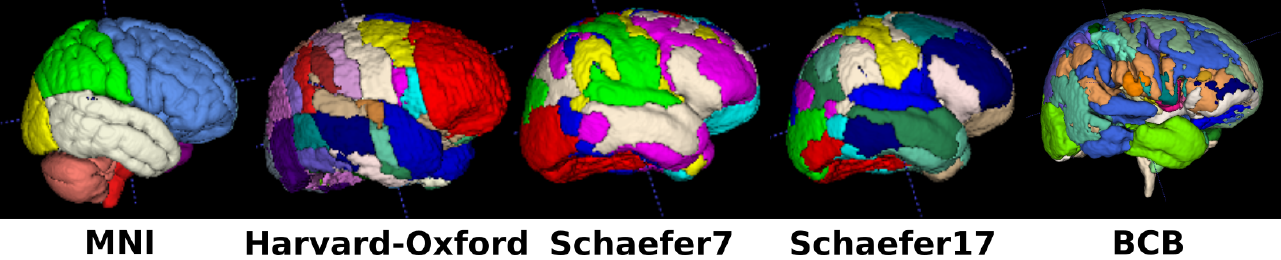
Figure 2. Illustration of the different atlases used for feature computation, all expressed in the MNI (Montreal Neurological Institute) space. Cortical structures atlases: MNI, Harvard-Oxford, Schaefer7, and Schaefer17. Subcortical structures atlases: BCB (Brain Connectivity